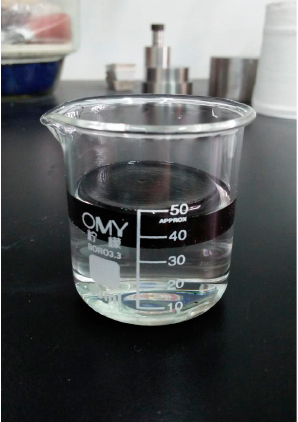
Figure 8. Experiments with the treated wood.